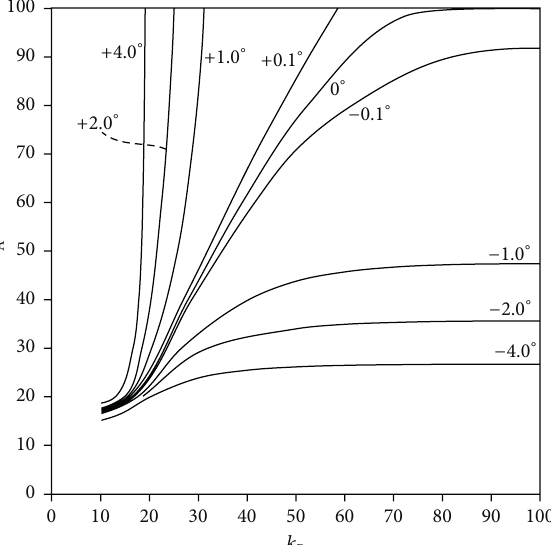
Figure7: Angledeviation inmovement of center ofmassfordifferentstiffnessinfrontandrear supportingpositionsaspercentage of nominal stiffness, empty screen.